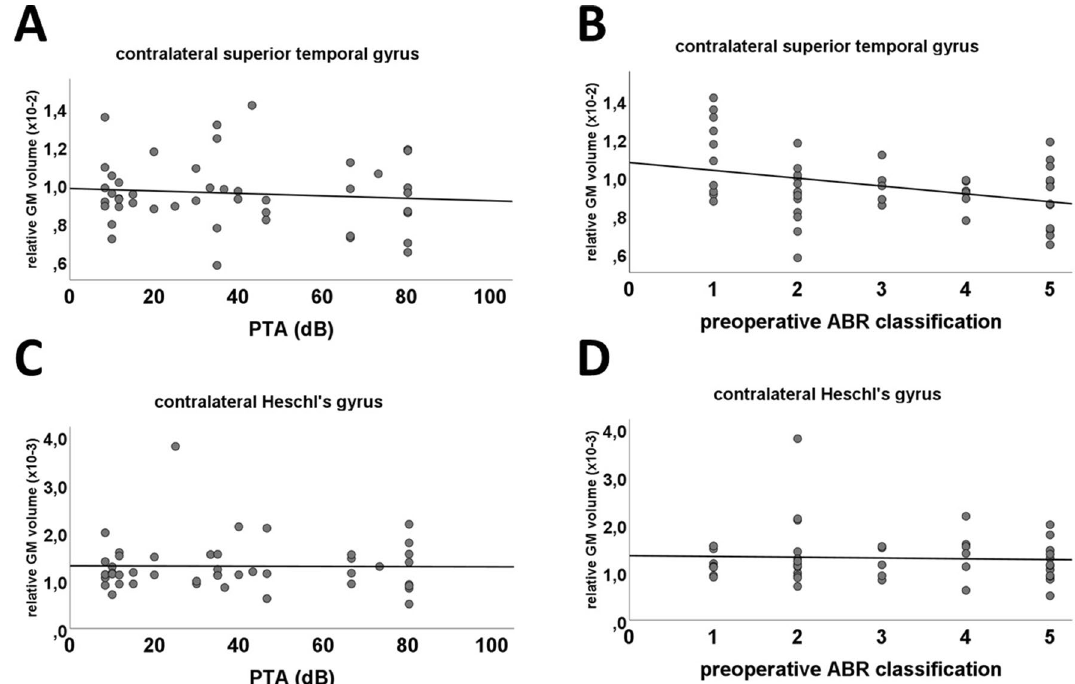
Figure 4. Correlation analysis showed no significant correlation between the relative GM volume of the contralateral superior temporal gyrus ( A,B ) or the contralateral Heschl’s Gyrus ( C,D ) to the